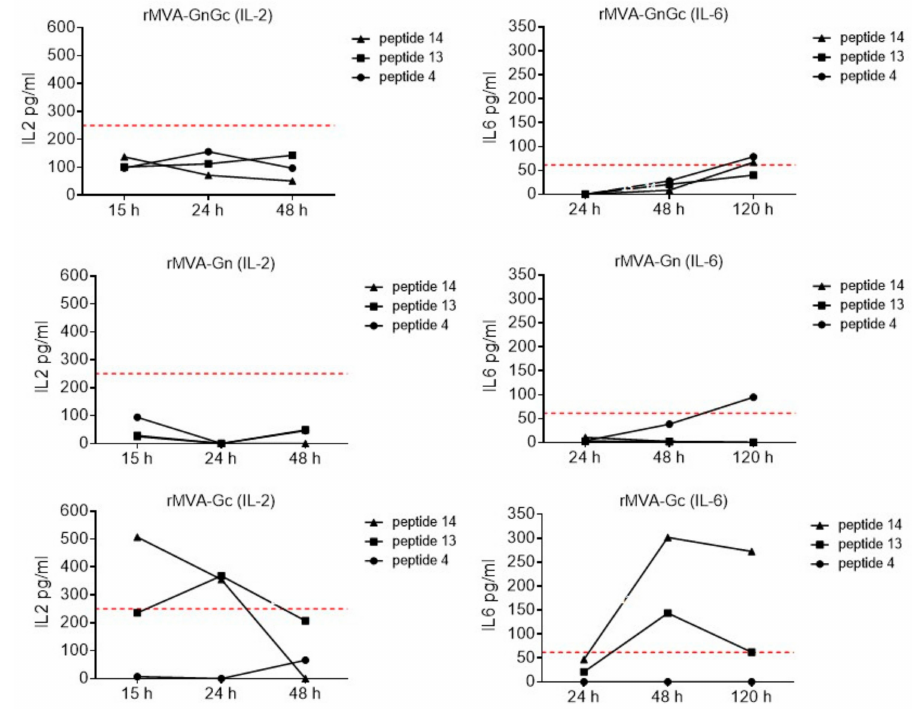
Figure 5. Detection of IL-6 and IL-2 secretion in ex-vivo restimulated spleen cells with peptides. The levels of each cytokine were estimated, using a capture ELISA, in supernatants collected at di ff erent times after stimulation. A standard curve was generated to correlate ELISA absorbance values with cytokine concentrations. The graph represents values after background subtraction from nonstimulated cells. The red dotted line determines the lower range of the standard